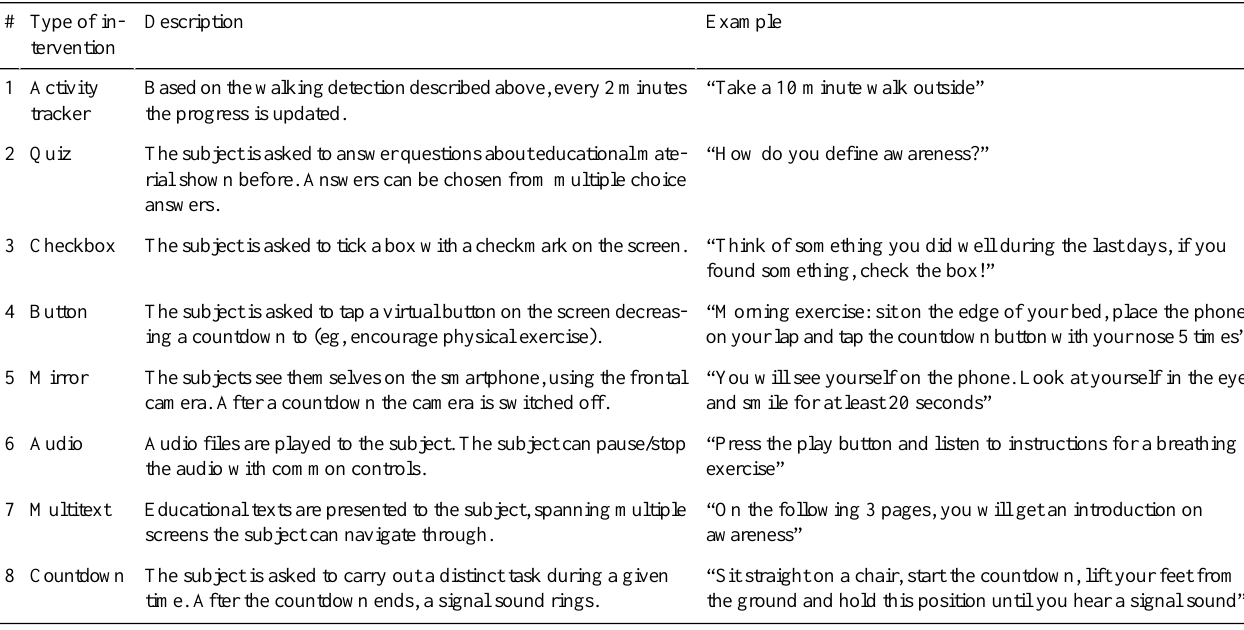
Table 2. Overview of interactive elements of the Mobile Sensing and Support (MOSS) app. ExampleDescriptionType of in- tervention# updated.Activity tracker1 the progress is